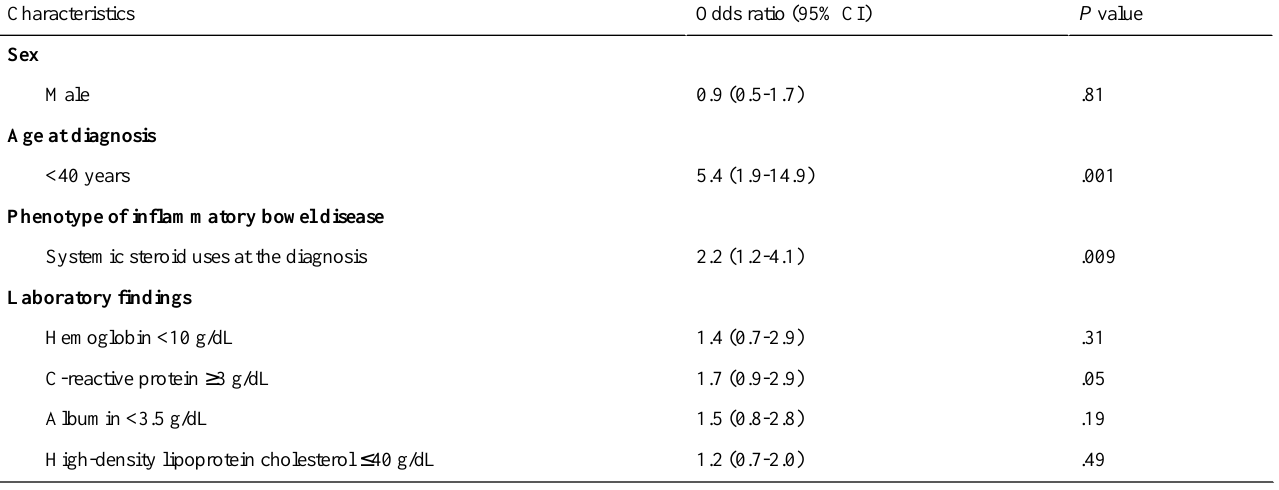
Table 5. Multivariate analysis for the detection of associative valuables with experience of biologic agent in Crohn's